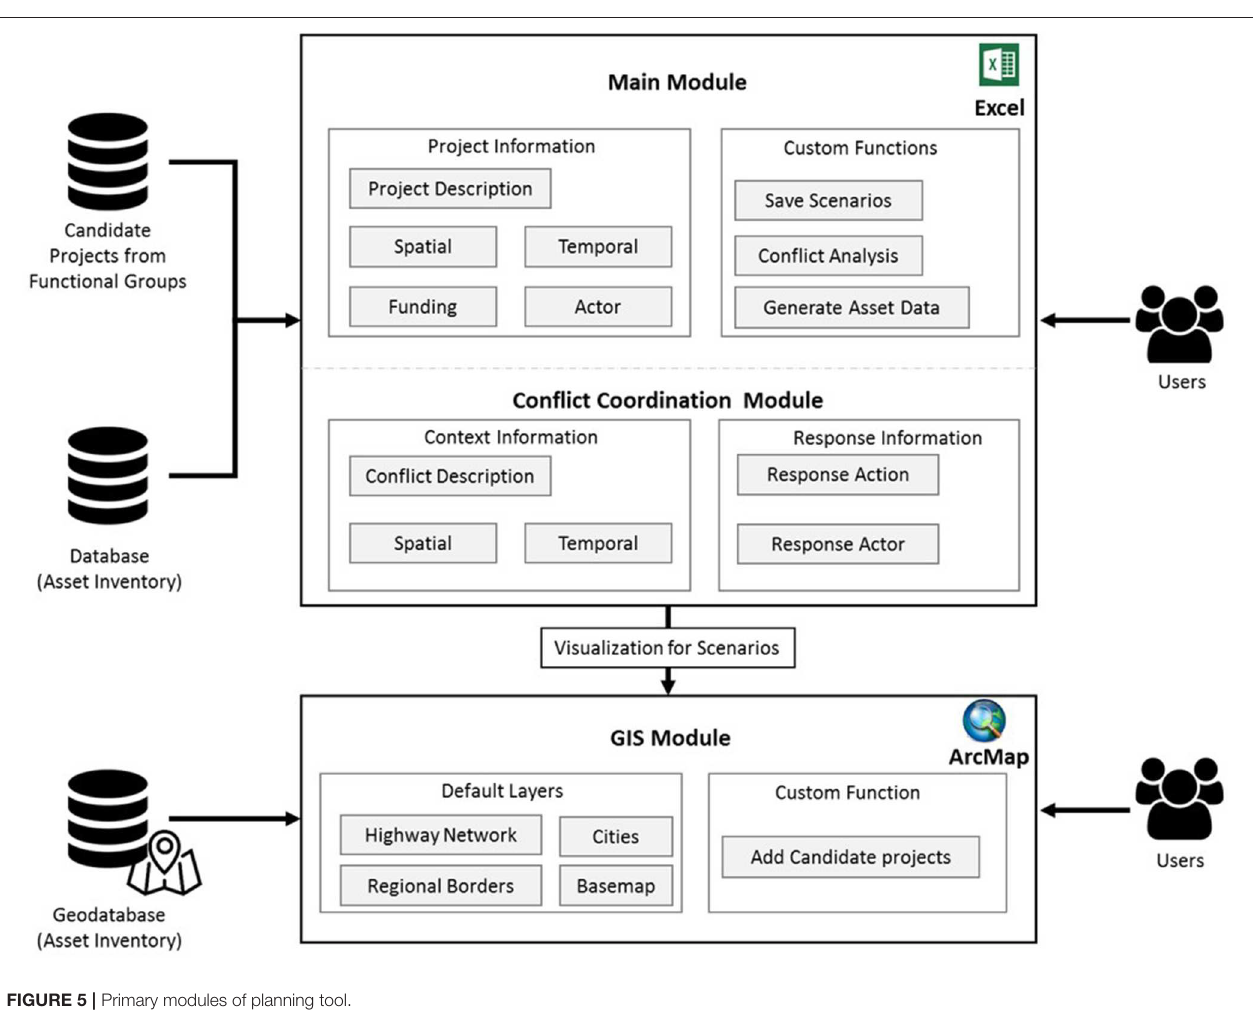
FIGURE 5 | Primary modules of planning tool.